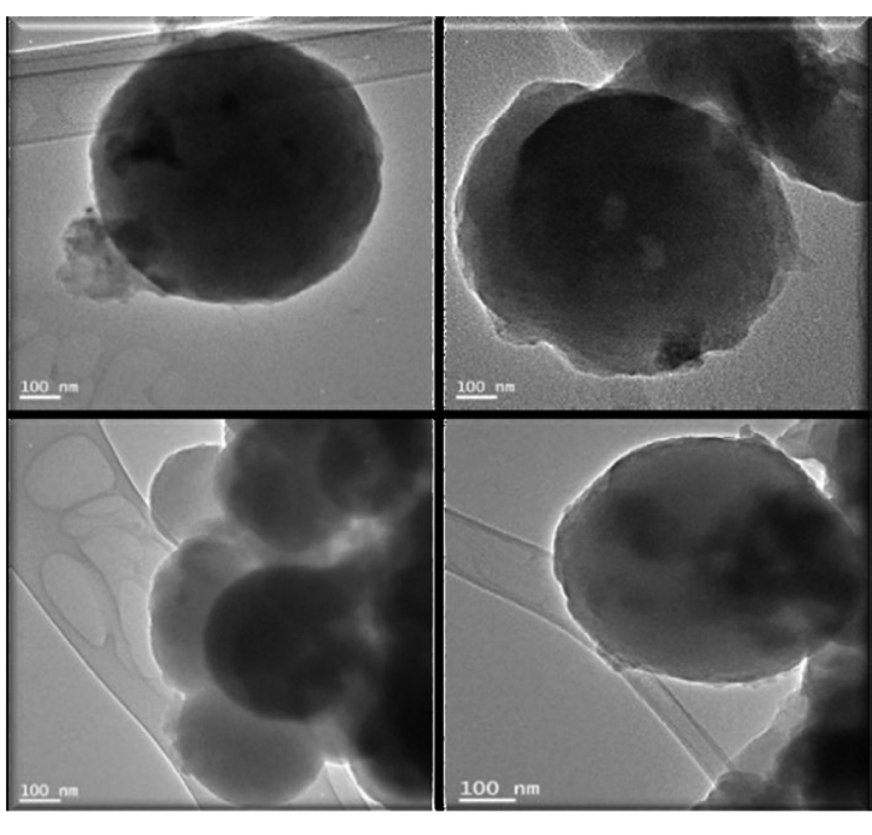
Figure 2: TEM image of CoMoS